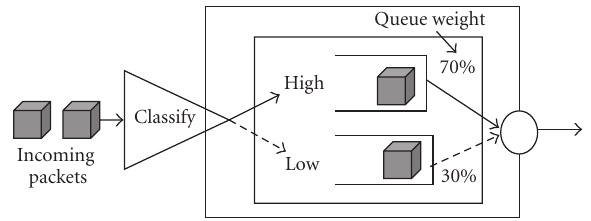
Figure 2: Class-based weighted fair queuing